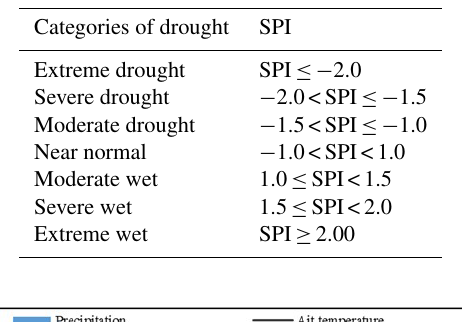
Table 2. Classification of drought calculated by the SPI.